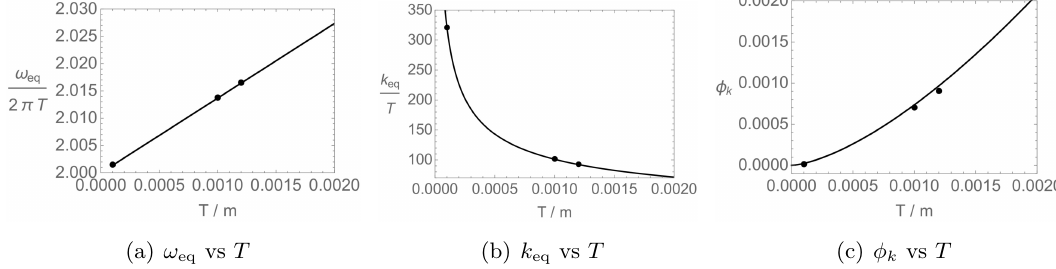
Figure 8 . The temperature dependence of ( ω eq , k eq , φ k ) for the linear axion model. Dots are numerical data and black solid lines are fitting curves